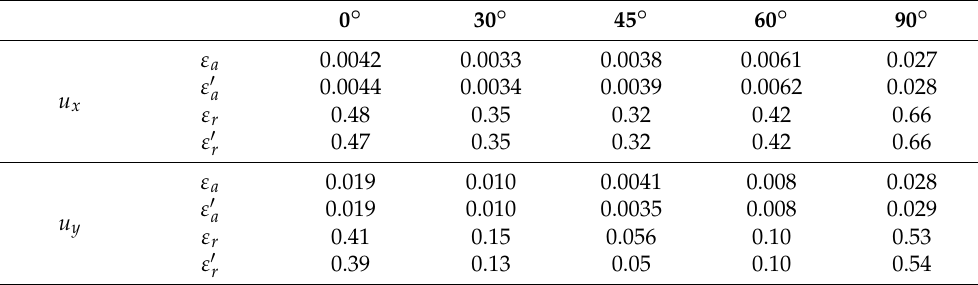
Table A6. Absolute and relative errors for the deep canyon. ε a , ε r are averaged over the whole canyon; ε (cid:48) a , ε (cid:48) r exclude the bottom log layer.